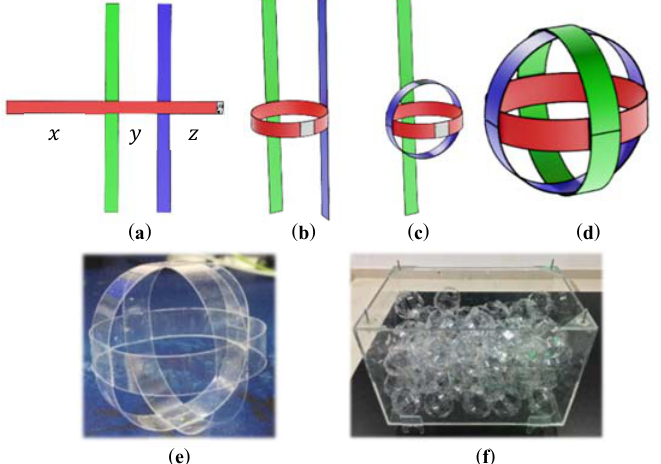
Figure 5. Baffle ball ( a – d ) sphere formation illustration, ( e ) baffle ball made from a thin PVC sheet, and ( f ) filling up the tank with baffle balls.